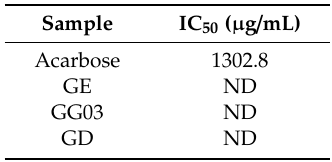
Table 3. Inhibitory e ff ects of GE, GG03 and GD on α